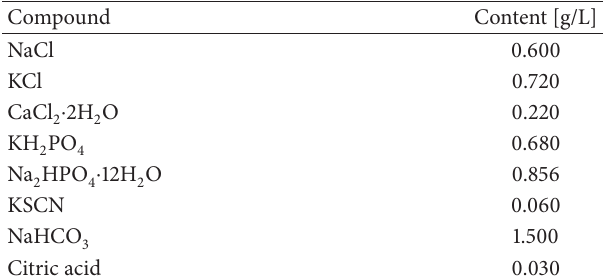
Table 2: Chemical composition of artificial saliva (pH = 6.5) [12].